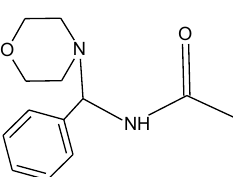
.MBA.2H O (A=Cu 4 2